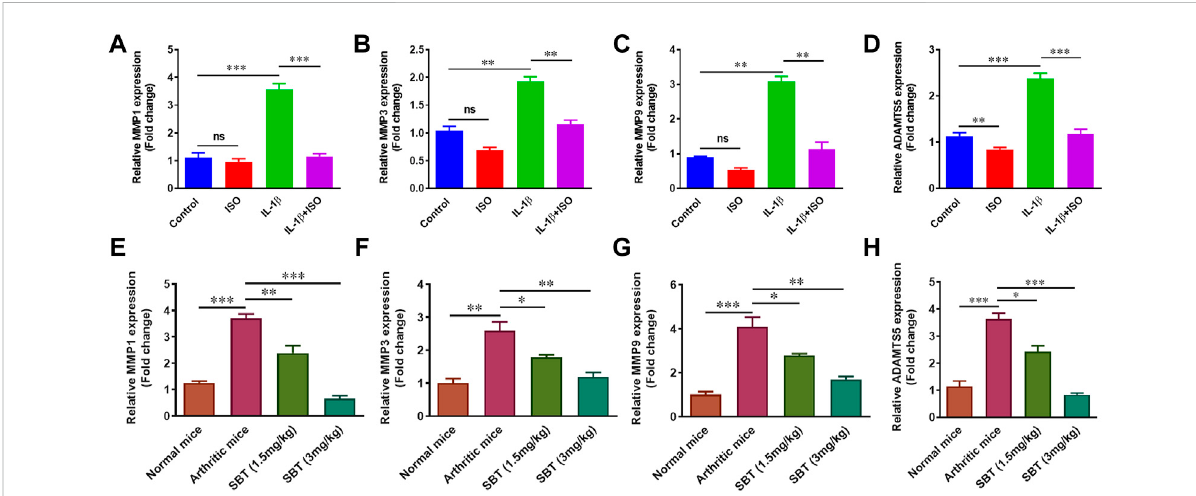
FIGURE 8 Gene expression analysisof Matrix degrading enzymes in vitro and in vivo . CHON-001 cells were treated with ISO(10 − 5 mol/L),IL-1 β (10 ng/ml) orcombinationofbothfor24 h.TotalRNAswereextractedtoperformtheqPCRfor MMP1 (A) , MMP3 (B) , MMP (C) and ADAMTS5 (D) .Micefromeach experimental group was euthanized on 28 th day. Murine chondrocytes were isolated to measure the gene expression level of MMP1 (E) , MMP3 (F) , MMP9 (G) and ADAMTS5 (H) byusingqPCRtechnique.Alltheexperimentswereperformedinduplicatemanner.DatawereanalyzedbyGraph- Pad prism version 7.0. Signi fi cance of data was measured by using One Way ANOVA. * p < 0.05, ** p < 0.01, *** p < 0.001, ns, not signi fi